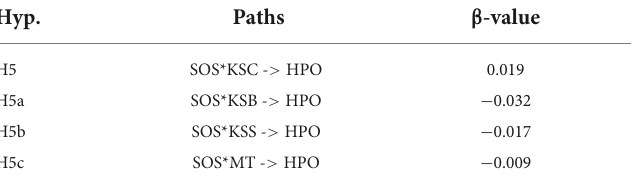
TABLE 8 R 2 and Q 2